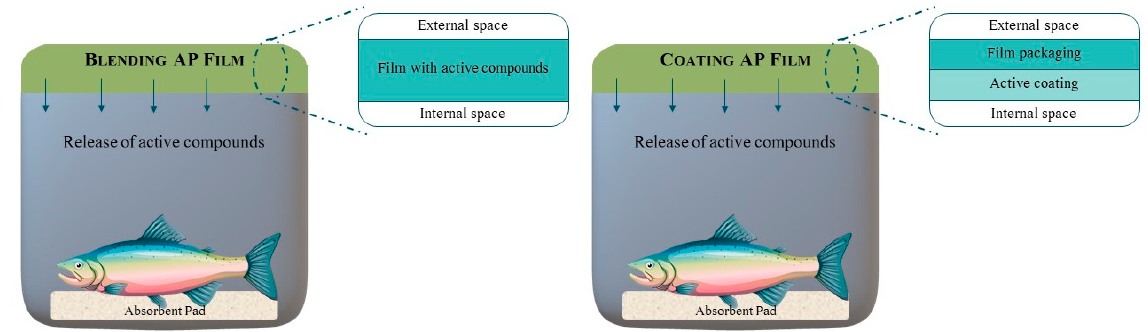
Figure 4. The graphic representations of blending and coating active packaging (AP) films applied to fishery products. Based on information available in [4].